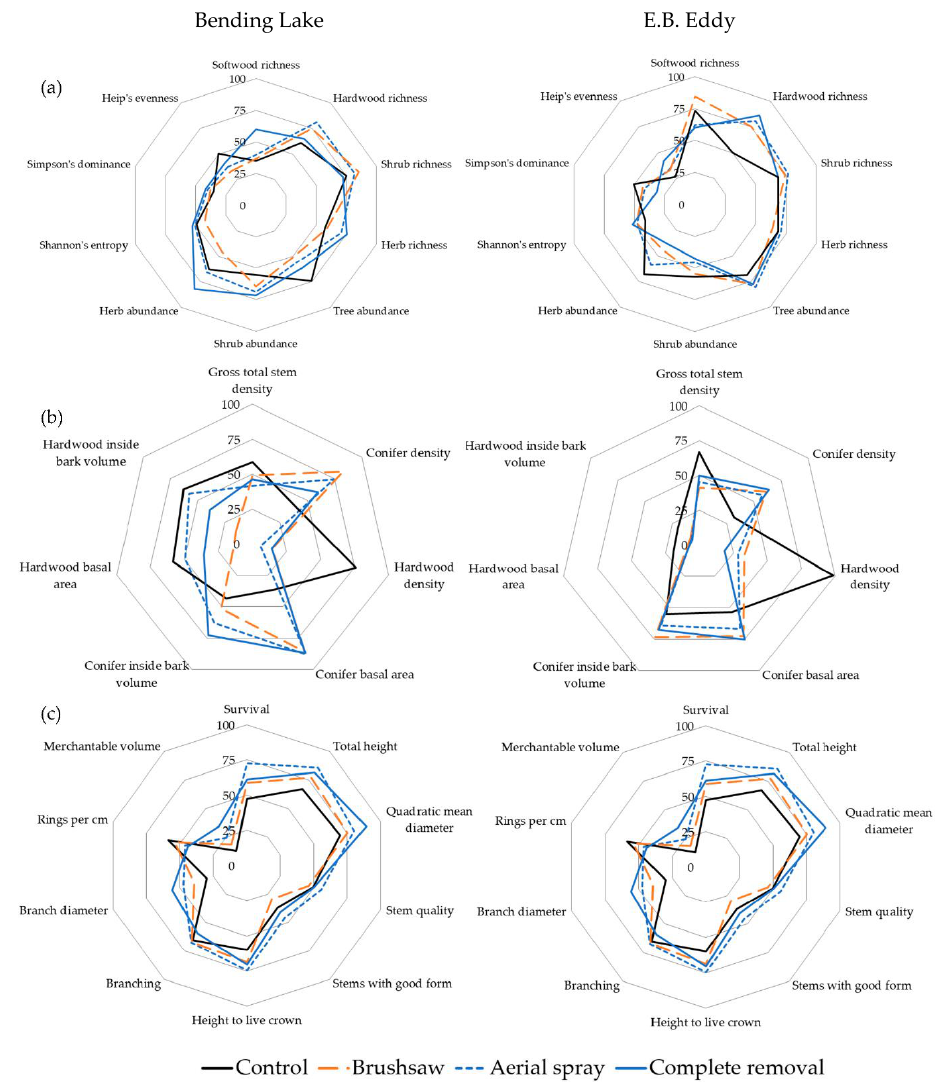
Figure 1. Radar diagrams proposed as a visual illustration of the effects of four release treatments on ( a ) plant biodiversity indicators, ( b ) stand-scale growth and yield indicators, and ( c ) individual crop tree growth indicators for two jack pine sites located in Ontario, Canada: Bending Lake and E.B. Eddy. Interior colored lines represent scoring for each criterion separated by treatment (aerial spray, motor-manual brushsaw, complete removal, and no competition control) 25 growing seasons after treatments applied. Values were calculated as percentage deviation from the baseline (ideal or maximum site